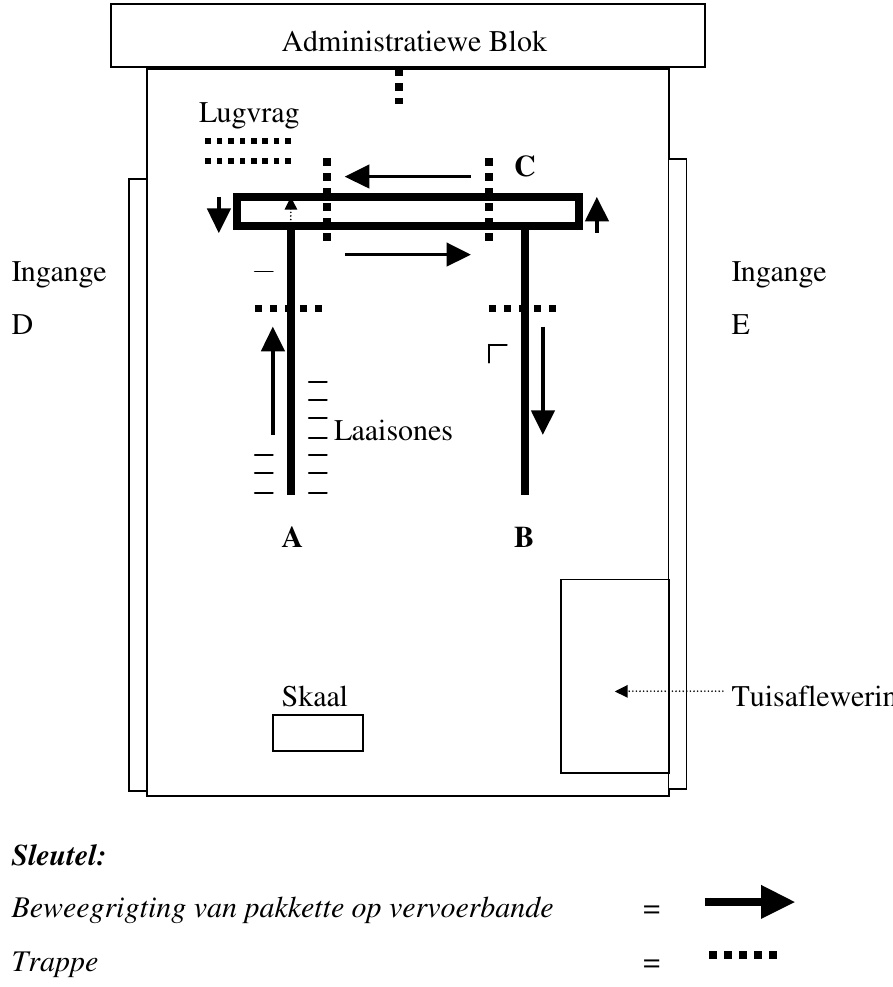
Figuur 1 ’n Skematiese voorstelling van die vloeruitleg van die